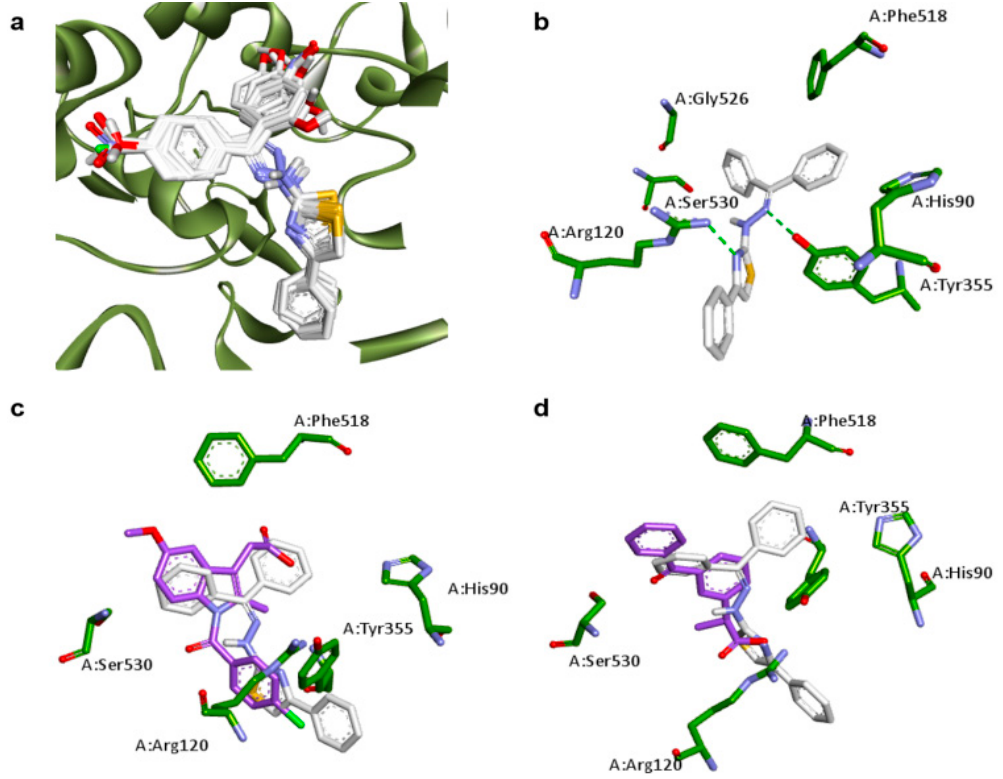
Figure 3. Docking results of planned compounds into COX-2 active site (PDB ID: 3NT1). ( a ) Conformation of planned compounds found in their most stable complex with COX-1; ( b ) Interaction of 3a (white carbons, yellow sulfurs, blue nitrogens and red oxygens) and COX-2 active site (green carbons). Hydrogen bonds (dotted green line) are indicated; ( c ) Conformation comparisons between 3a (white carbons) and indomethacin (purple carbons) interacting with COX-2 (green carbons); ( d ) Conformation comparisons between 3a (white carbons) and ketoprofen (purple carbons) interacting with COX-2 (green carbons).